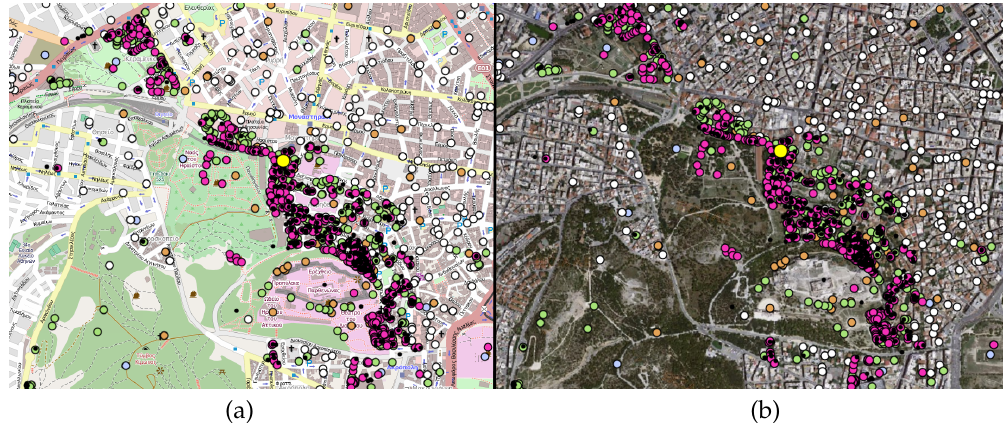
Figure 14: Position of points of interest over (a) OSM and (b) satellite image.